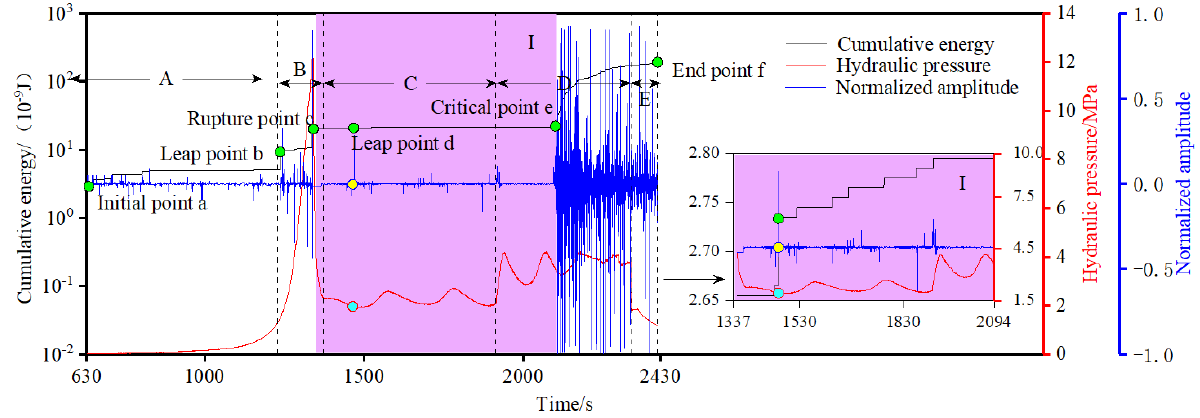
Figure 7. AE energy and normalized amplitude curve in true triaxial HF.